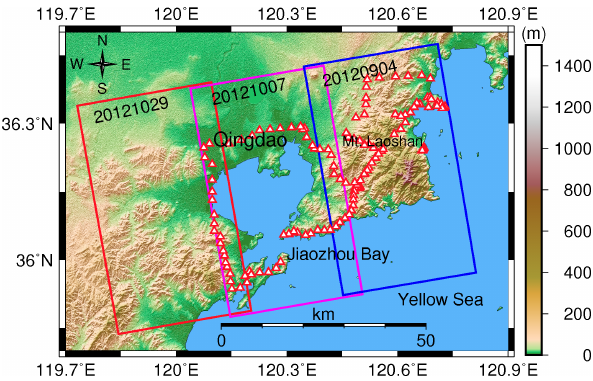
Figure 1. Location of study site with the coverage of TanDEM-X DEM (three rectangles) and GPS observations (red